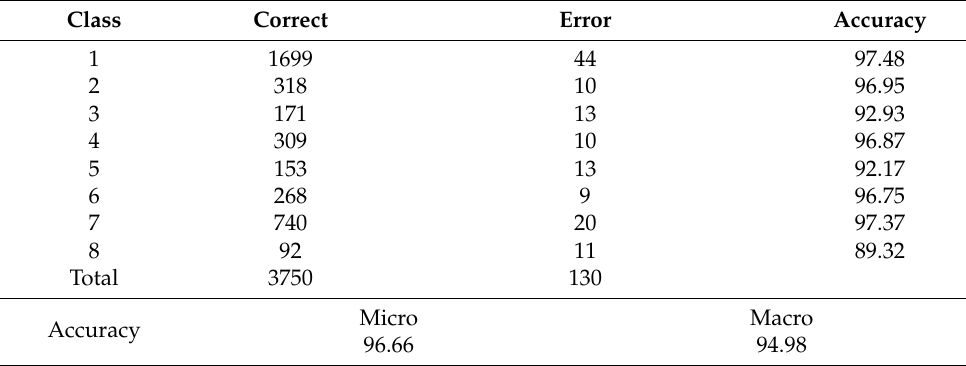
Table 6. Performance for each label measured in Task 1 of accident type